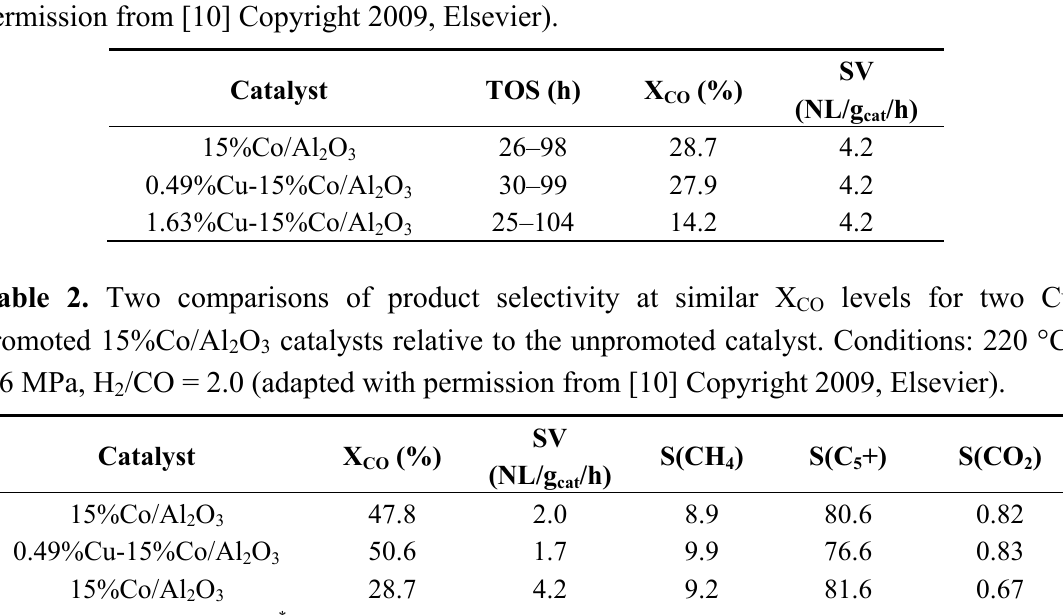
O catalysts at a SV of 4.2 NL/g /h relative 2 3 cat /CO = 2.0 (adapted with 2